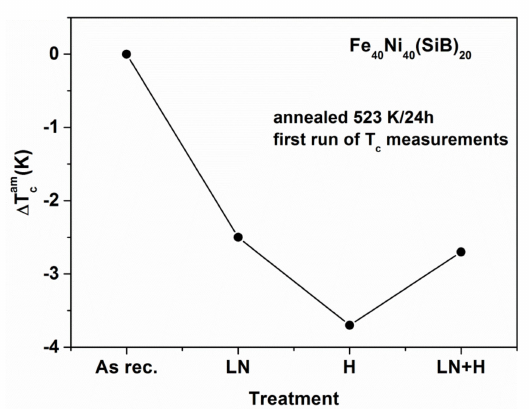
Figure 41. Comparison of the sign and magnitude of ∆ T Cam observed during the first run of T Cam measurements (heating rate 20 K // min.). Adopted from [87], with permission from BENTHAM Open, 2010.